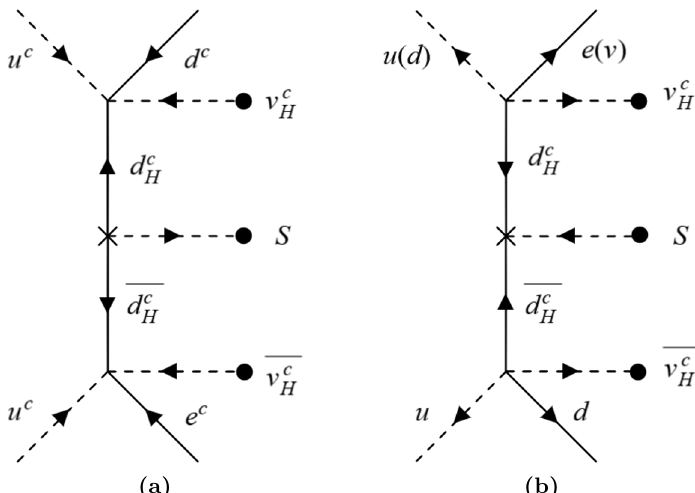
Figure 1. Dimension-(cid:12)ve proton decay diagrams. Dashed lines represent bosons, solid lines repre- sent fermions, and dots represent the vevs. These are graphs between the B -violating superpoten- tial coupling F c F c H c H c ( FFH c H c ) and the B -conserving superpotential coupling F c F c H c H c ( FFH c H c ). The fermionic or bosonic character of the external lines in each vertex can be inter- changed